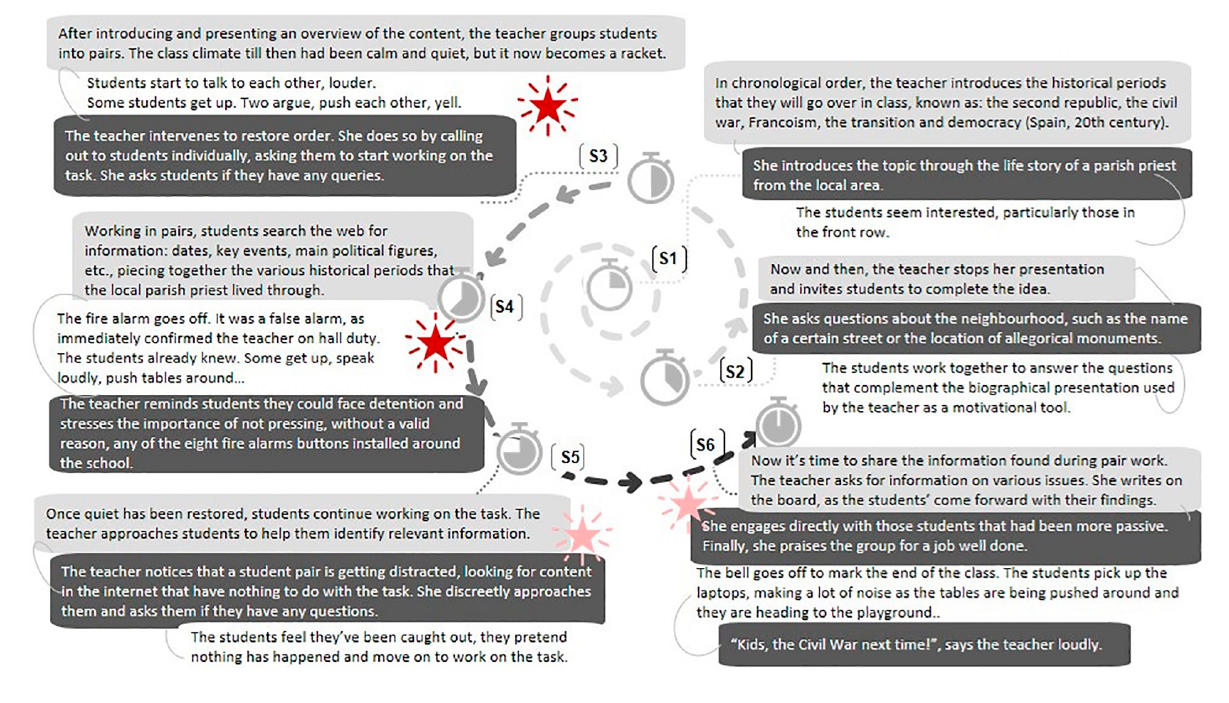
lesson, the teacher left the way open for the next lesson with a motivational message: “Kids, the Civil War next